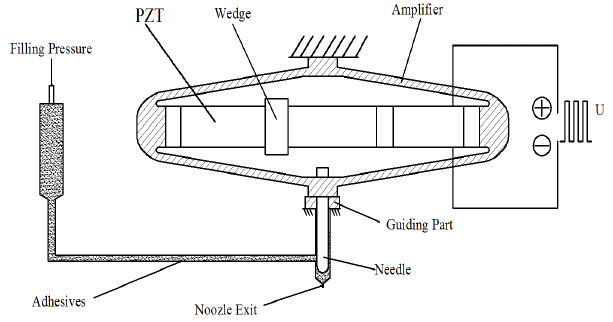
Figure 1. Piezo jet dispenser.